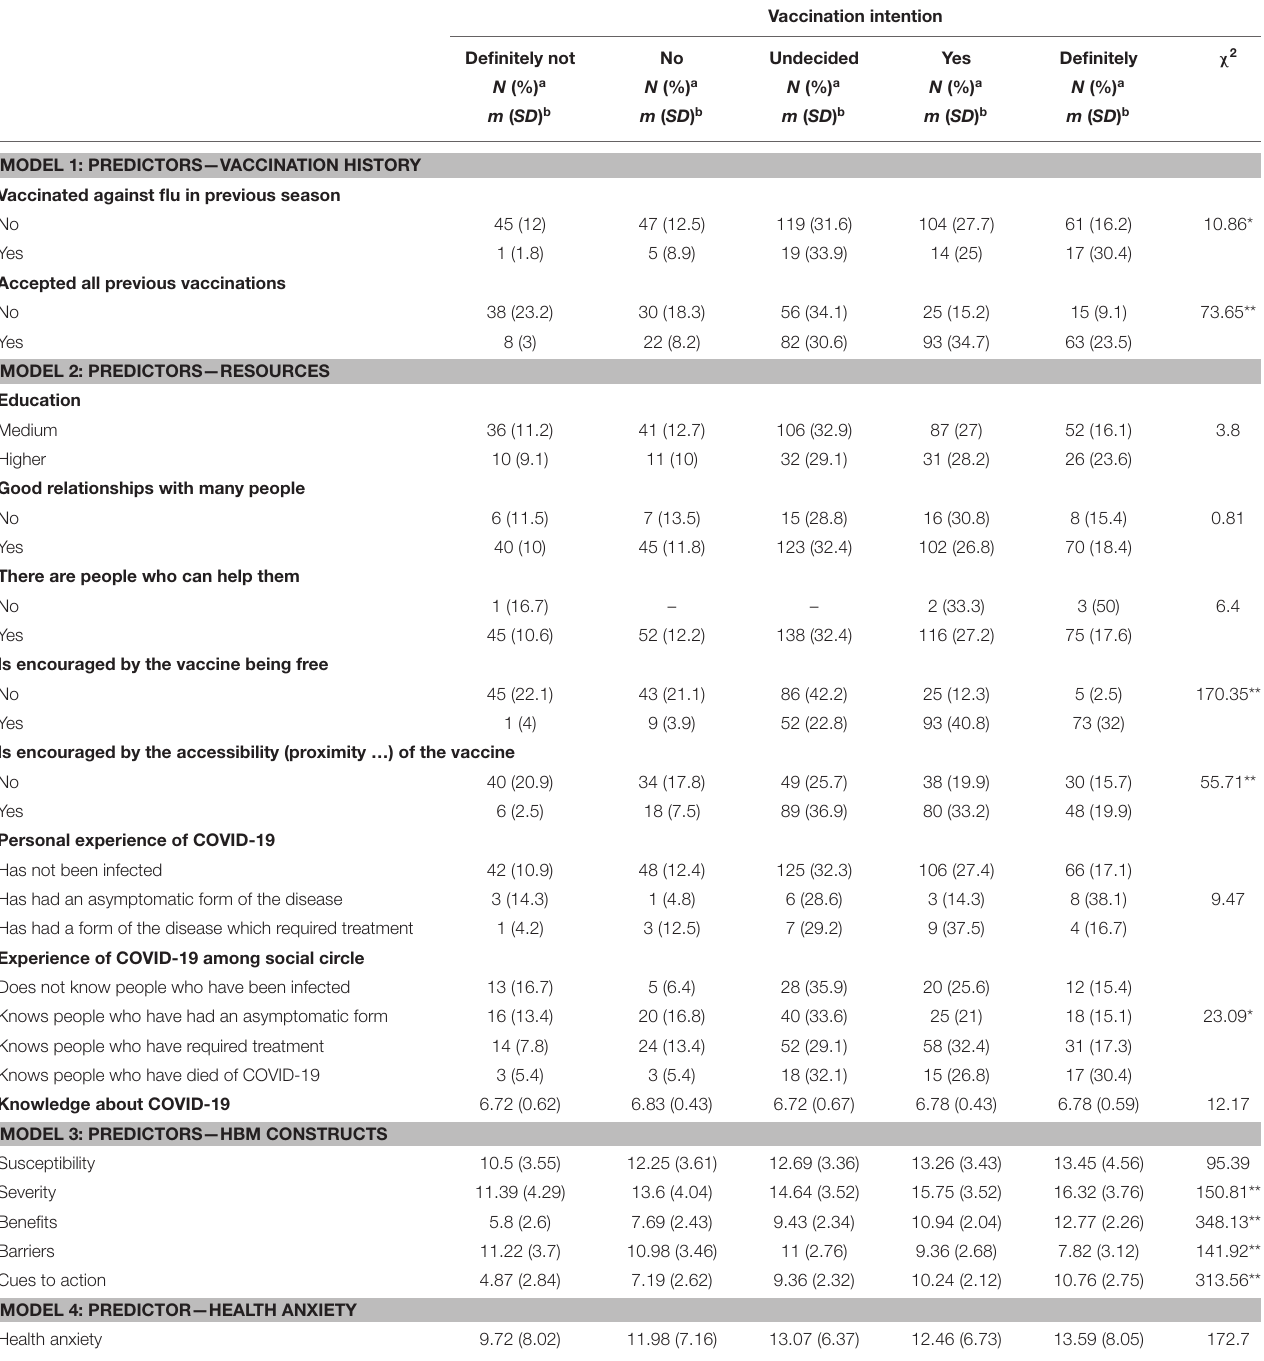
TABLE 3 | Association between possible predictors and vaccination